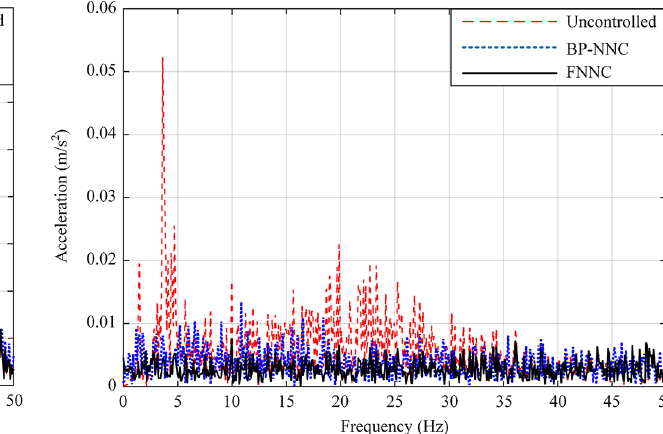
Fig. 29. Frequency-domain response of horizontal vibration acceleration of the elevator car frame with a medium